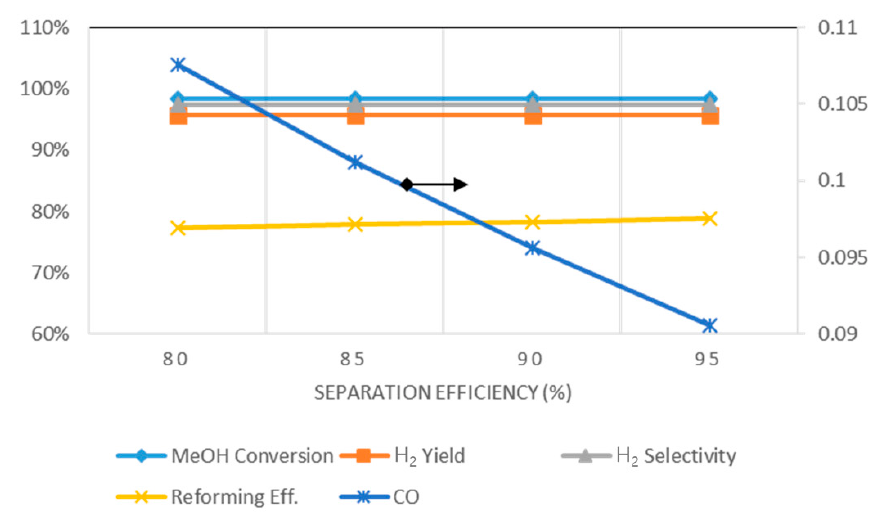
Figure 13. E ff ect of Separation e ffi ciency on MeOH conversion, H 2 yield, H 2 selectivity, reforming e ffi ciency and CO flow Figure 13. Effect of Separation efficiency on MeOH conversion, H 2 yield, H 2 selectivity, reforming efficiency and CO flow rate.